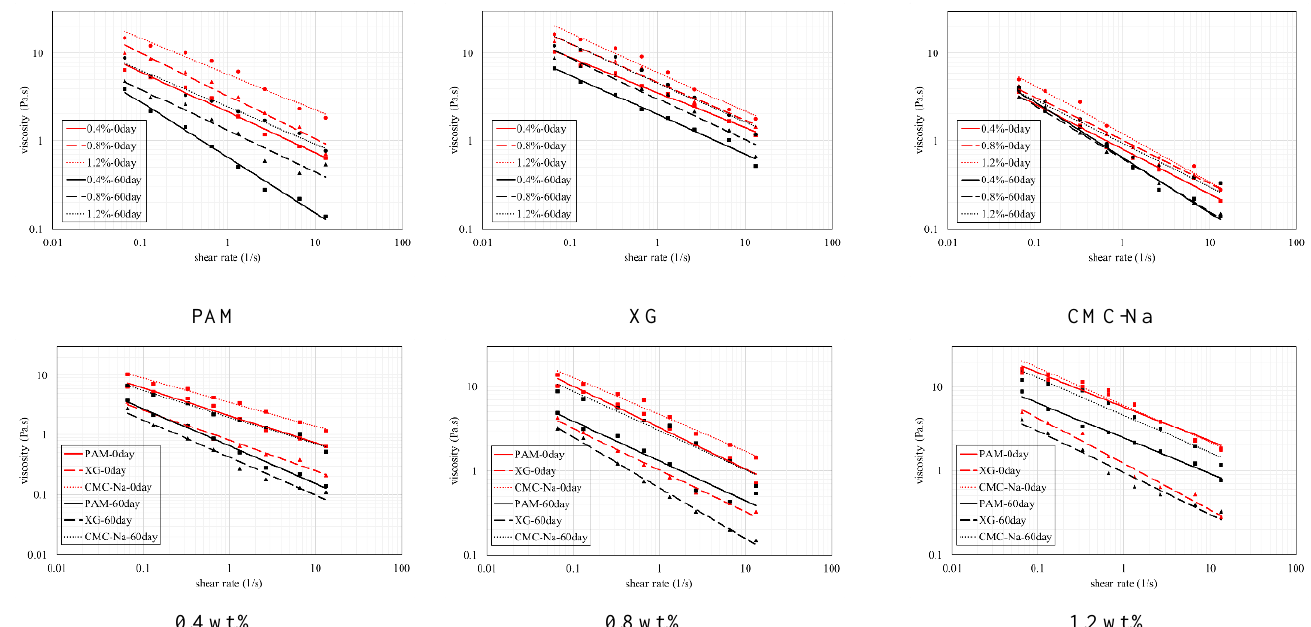
Figure 5. Dynamic viscosity comparison of single polymers at different aging time-nodes. Table 1. Fluid parameters of polymer solution before and after self-aging. PAM con. (wt.%)